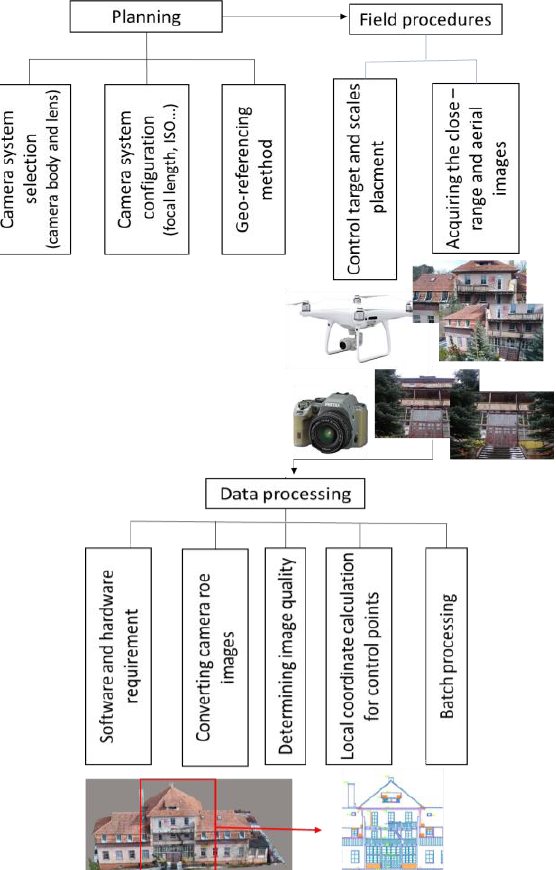
Figure 3. A schematic diagram of the photogrammetric work stages